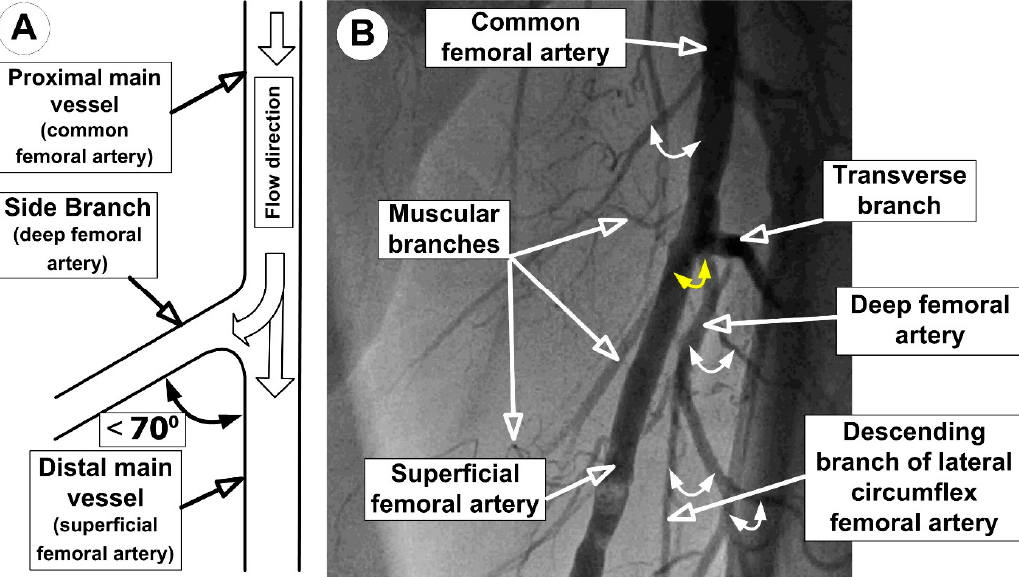
Figure 1. (A ) Schematic representation of the arterial bifurcation. The yellow arrow indicates bifurcation between the superficial femoral artery and deep femoral artery. (B ) An angiographic image of femoral artery bifurcations. artery